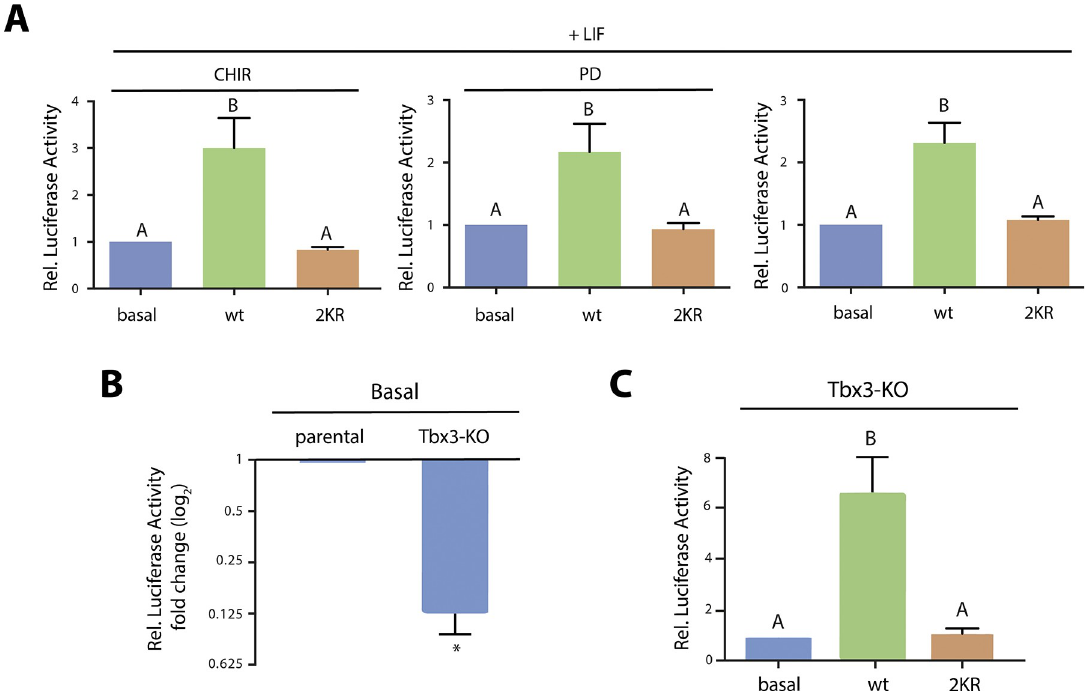
Fig 3. GSK3- β and Tbx3 are non-essential factors for the effect exerted by SUMOylatable Akt1. (A) ES cells were transfected with Nanog5P reporter along with an expression vector encoding for either wt Akt1, the Akt1 mutant 2KR or the empty vector (basal), as indicated under each bar. Cells were maintained in standard ES cell medium in the presence of LIF and either CHIR 99021 (CHIR) or PD 0325901 (PD), as indicated in each panel. Luciferase activity was measured in cell extracts obtained 72 h after transfection. Results were referred to the control (basal) of each condition and are shown as mean ± SEM of three independent experiments. Statistical analysis was performed by linear mixed models (LMM) with a randomized block design (RBD). Comparisons were performed using the Tukey’s HSD test. Different letters indicate significant differences between treatments (p < 0.05). (B,C) wt and Tbx3-KO ES cells were maintained in standard ES cell medium (LIF+2i). Transfection and luciferase activity measurement was performed as indicated above. Results were referred to the control condition (B: parental, C: basal) and are shown as mean ± SEM of three independent experiments. Statistical analysis was performed by linear mixed models (LMM) with a randomized block design (RBD). Significant differences were assessed using the Tukey’s HSD test (p < 0.01, panel B). Asterisk indicates significant differences between the Tbx3 KO ES cell line and the parental ES cell line and different letters indicate significant differences among conditions (p <